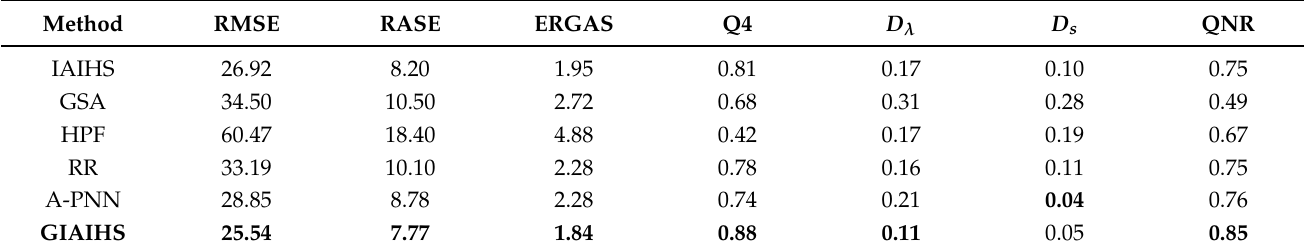
Table 1. Experiment with six PS methods on QuickBird satellite data.